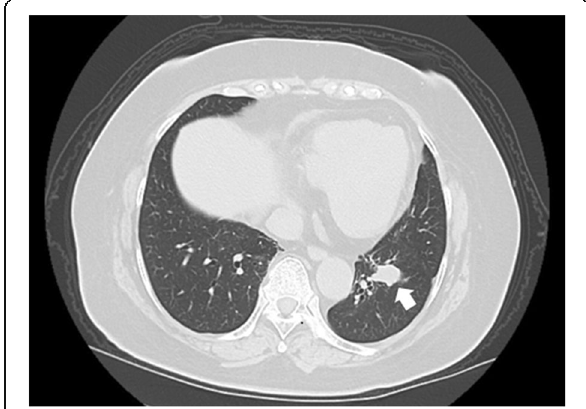
Fig. 1 Computed tomography revealed a well-demarcated tumor,